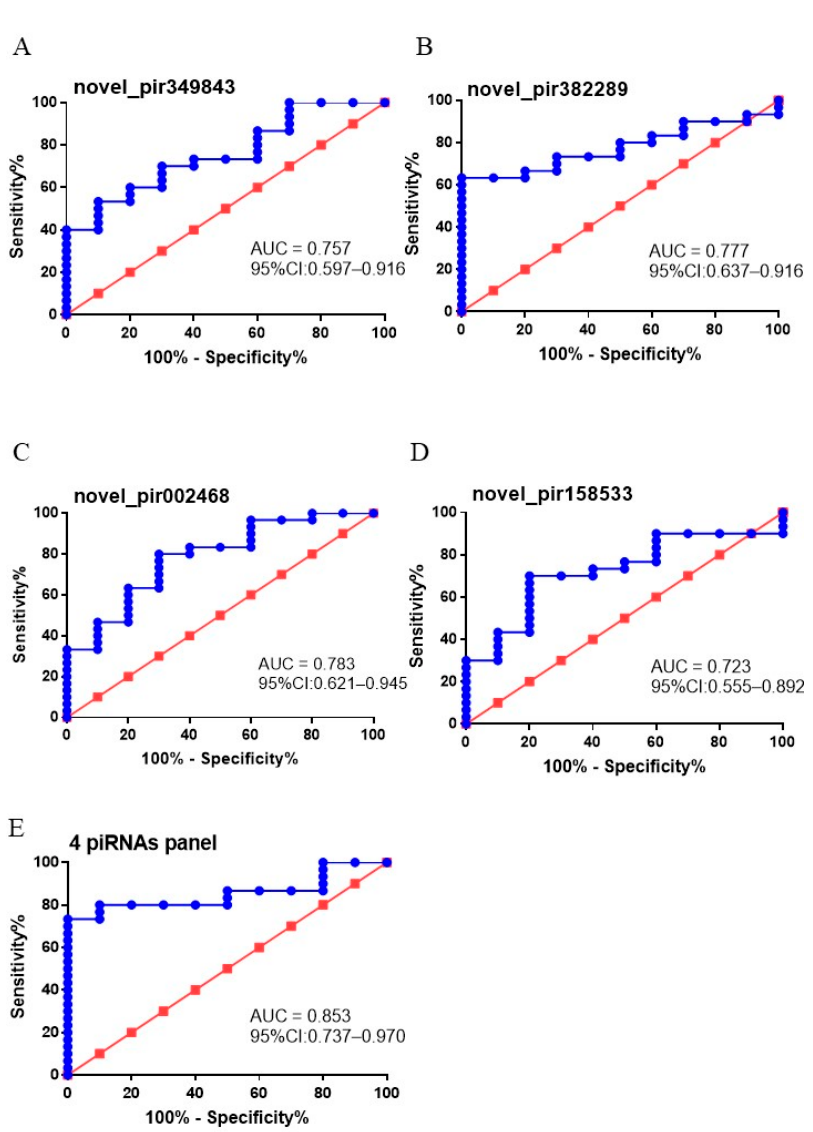
Figure 3 . Clinical utility of urinary EVs piRNAs in the diagnosis of PCa. The ROC curves for ( A ) novel_pir349843, ( B ) novel_pir382289, ( C ) hsa_piR_002468, ( D ) novel_pir158533, and ( E ) a combination of the four piRNAs.